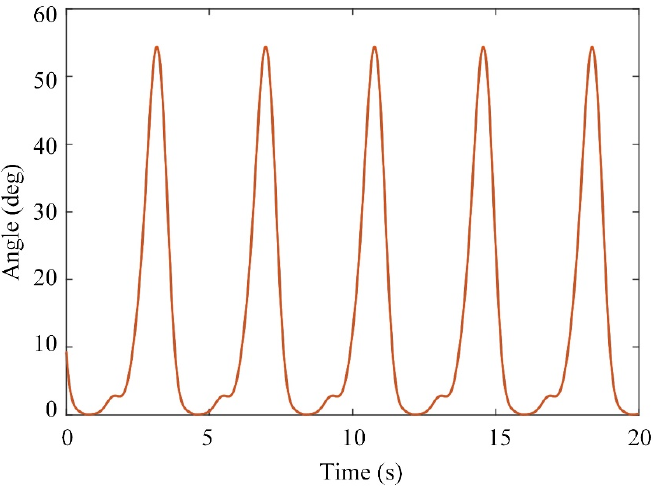
Figure 8. Desired Figure 8. Desired trajectory. Figure 8. Desired trajectory.